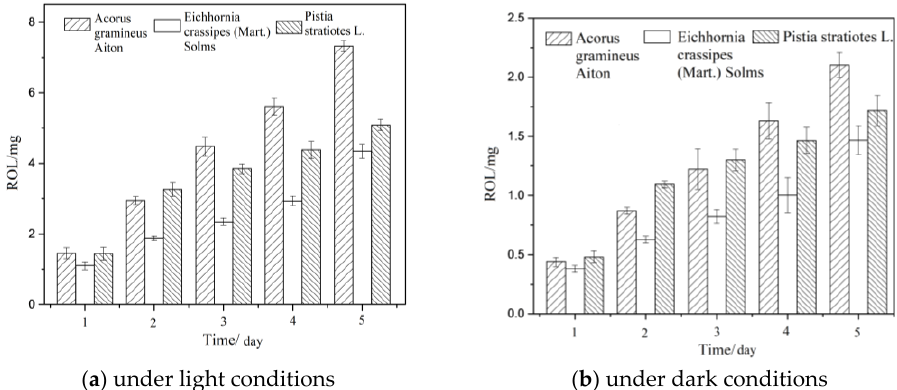
Figure 3. The ROL of wetland vegetation under light conditions and dark conditions.